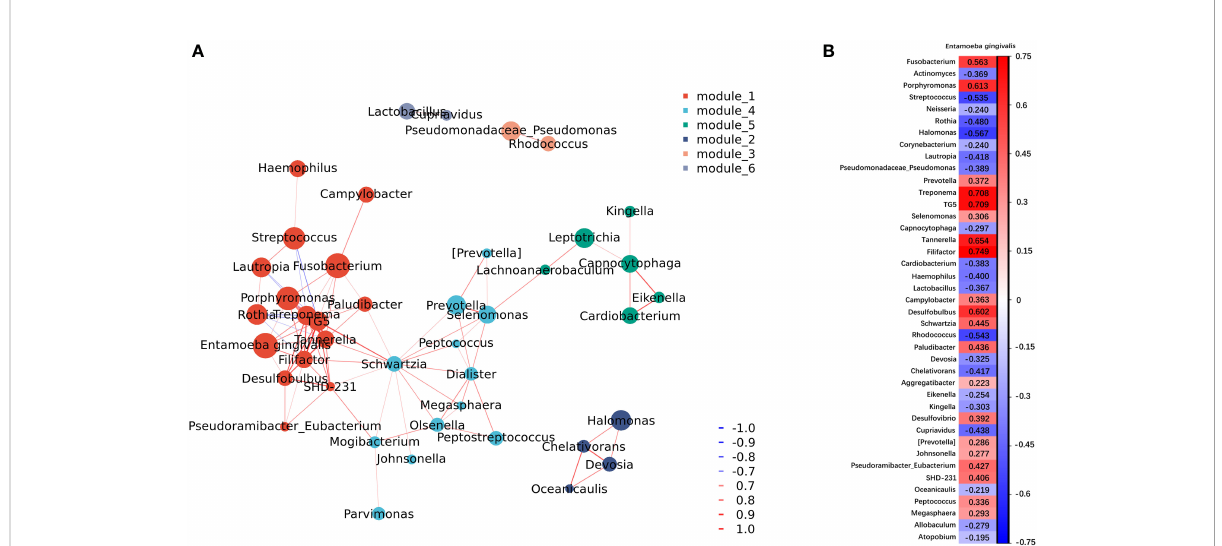
FIGURE 3 Co-occurrence network analysis between microorganisms at the genus level. (A) Network of co-occurrence showing the correlation between Entamoeba gingivalis ( E. gingivalis ) and the top 50 abundant bacteria genera with a coef fi cient |r|>0.6. Six modules were classi fi ed according to the intensity of their relationship. Each genus is colored according to the module it belongs to. The color intensity of connecting lines re fl ects the correlation coef fi cient, while the node size re fl ects the abundance. Red and blue lines represent positive and negative correlations, respectively. (B) The results of the co-occurrence network analysis between E. gingivalis and the top 50 abundant bacteria genera with a p < 0.05. The color intensity of grids re fl ects the strength of the correlation. Red and blue represent positive and negative correlations, respectively. The numbers are the correlation coef fi